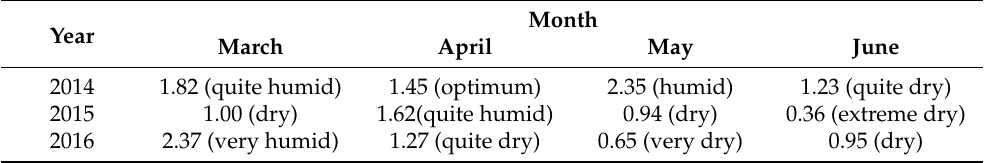
Table 1. Values of the Selyaninov hydrothermal coefficient (HTC).